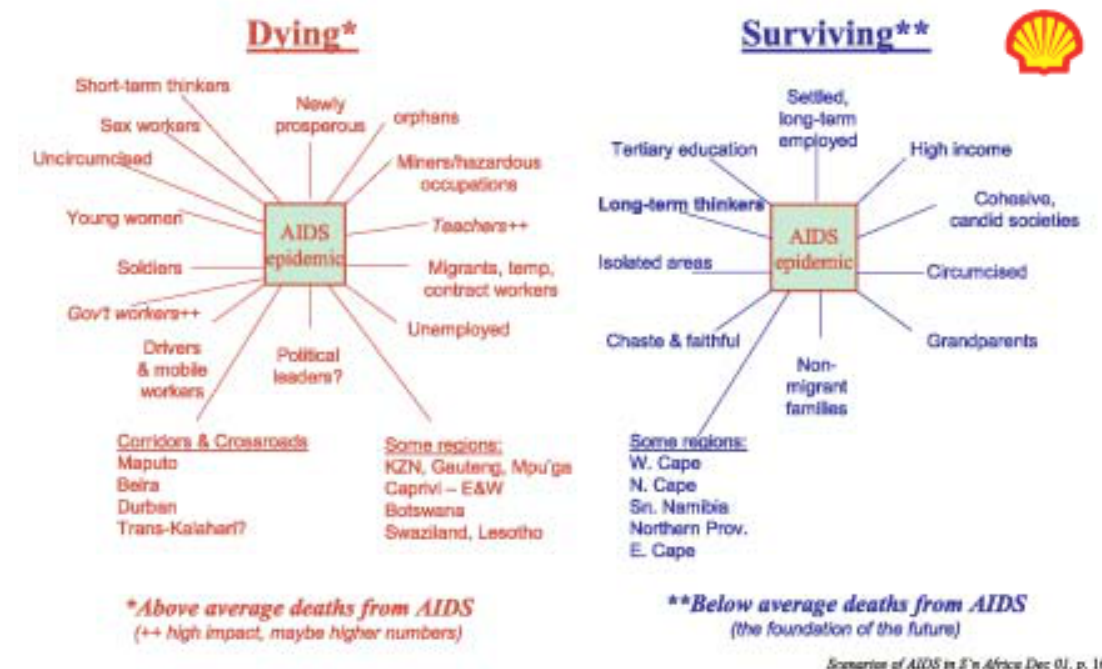
Fig. 1. Some populations harder hit by HIV/AIDS than others (slide developed for Shell South Africa by B Heinzen and HEARD,